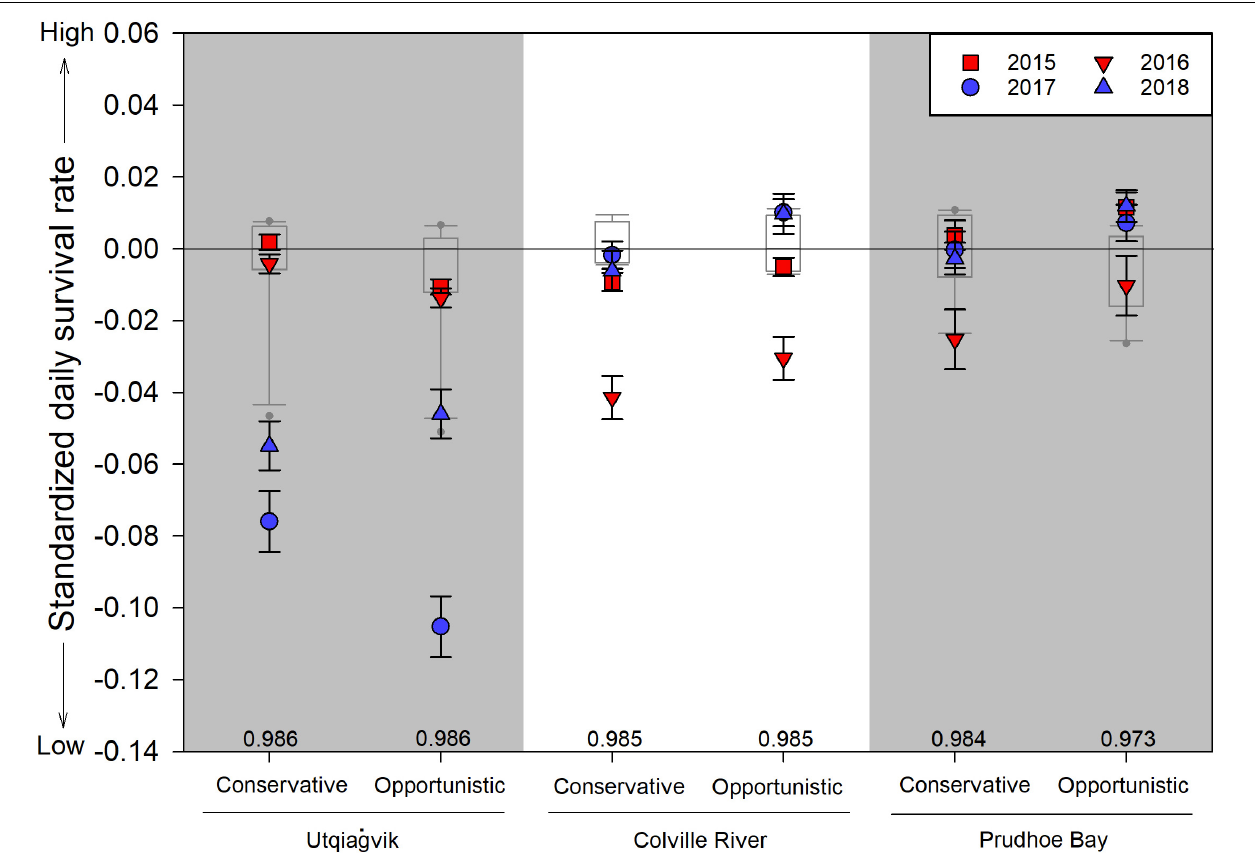
FIGURE 6 | Standardized daily survival rate ± SE of shorebird nests by conservative and opportunistic reproductive strategies in 2015–2018 in relation to long-term values (i.e., Utqia˙gvik: 2005–2014; Colville River: 2011–2014; Prudhoe Bay: 2005–2014). Data are standardized for each year and reproductive strategy separately by subtracting from them the long-term median value (median values listed above x-axis); box plots represent the 25 th and 75 th percentiles with error bars at the 10 th and 90 th percentiles and the line crossing at the median value. Early springs (i.e., 2015 and 2016) are illustrated in red while late springs (i.e., 2017 and 2018) are illustrated in blue. Values estimated for mean nest initiation date (i.e., 14 June, 13 June in leap years) based on parameter estimated from the top-ranked model (Daily nest survival site ∗ year ∗ strategy + initiation ). See Table 2 for species assignments to reproductive strategies and sample